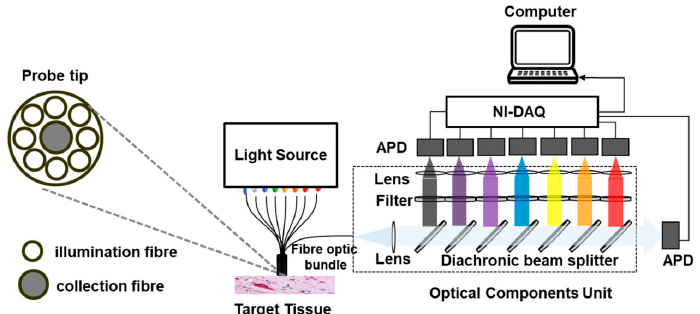
Figure 7. Instrumentation used in the Tissue Recognition project. Reprinted with permission from [2]. © The Optical Society 2022.